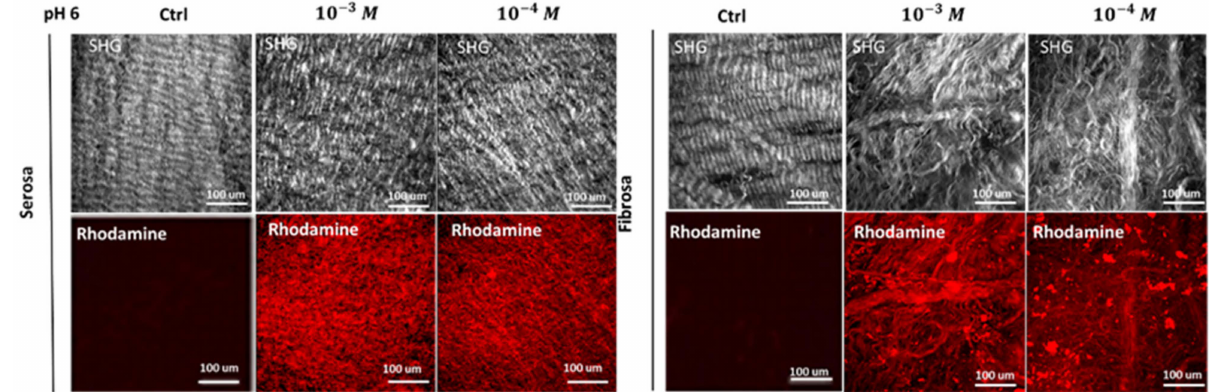
Figure 1. Determination of surface peptide density. The concentrations of REDV (10 − 4 M or 10 − 3 M) solution used to functionalize DBP scaffolds have produced different final quantities of peptides bound to the tissues.